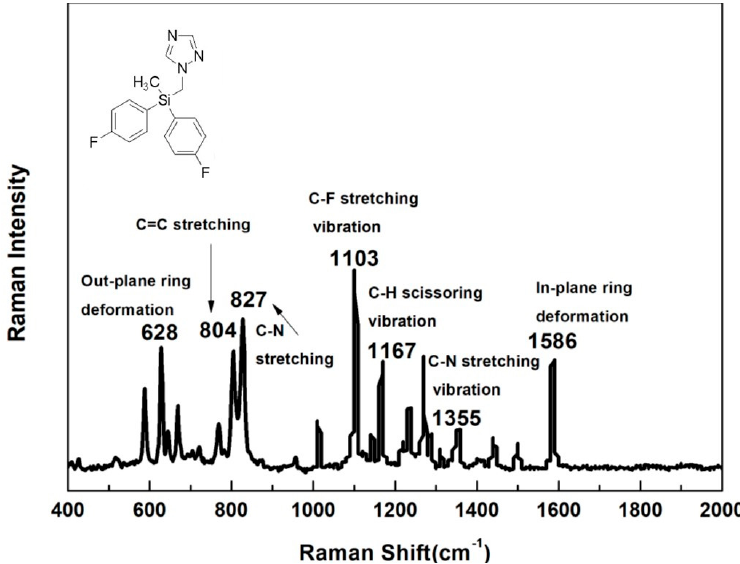
Figure 1. Molecular structure, Raman spectra and the band assignments for characteristic peaks of flusilazole. of